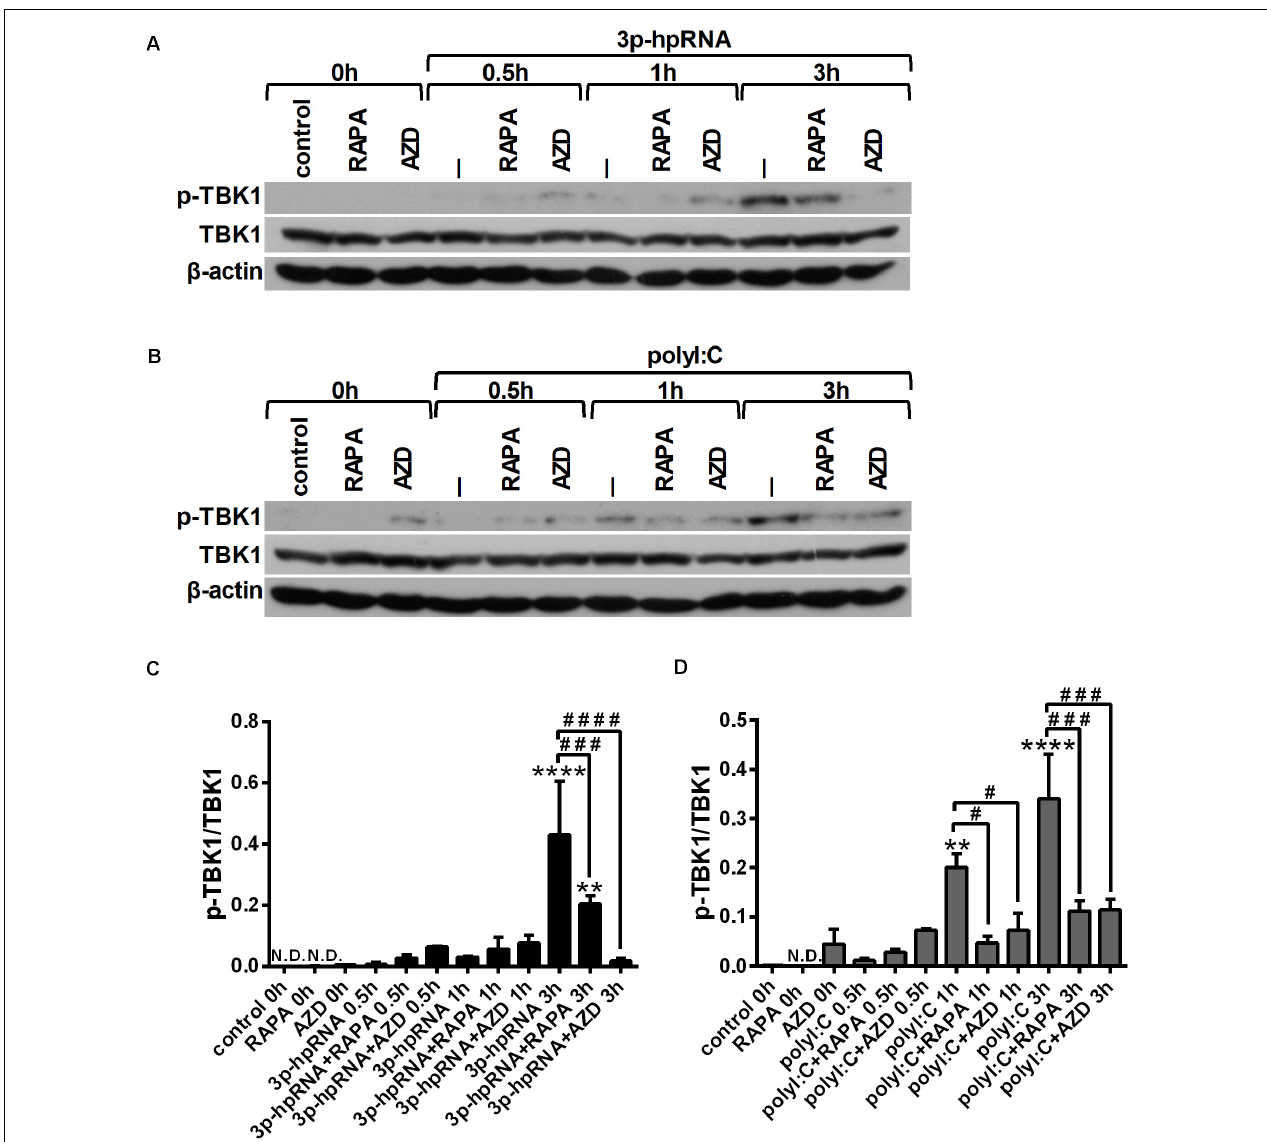
FIGURE 7 | RLR stimulation increases the phosphorylation of TBK1 that is reduced by rapamycin and AZD8055 pre-treatment in GEN2.2 cells. Cells were pre-treated with vehicle control, 100 nM rapamycin (RAPA) or 100 nM AZD8055 (AZD) for 2 h then stimulated with 3p-hpRNA (0.5 µ g/ml) (A,C) or polyI:C (1 µ g/ml) (B,D) for different time periods. Kinetics of TBK1 phosphorylation were determined by western blotting. (A,B) Representative blots are shown. (C,D) Bar graphs represent the mean ± SD of at least 3 independent experiments. ** p < 0.01, **** p < 0.0001 vs. control; # p < 0.05, ### p < 0.001, #### p < 0.0001. ND, not